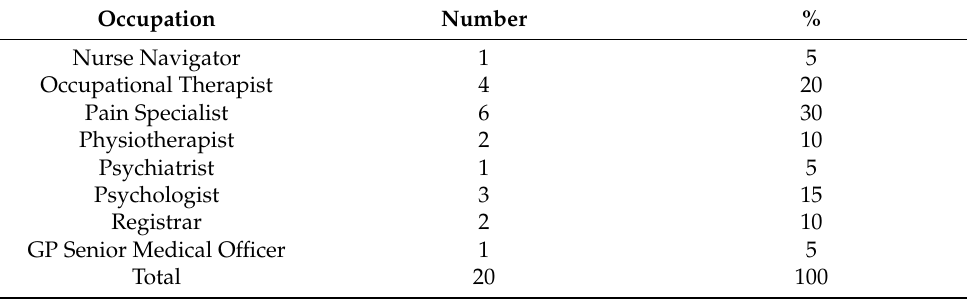
Table 3. Number of clinicians who participated in the focus group by